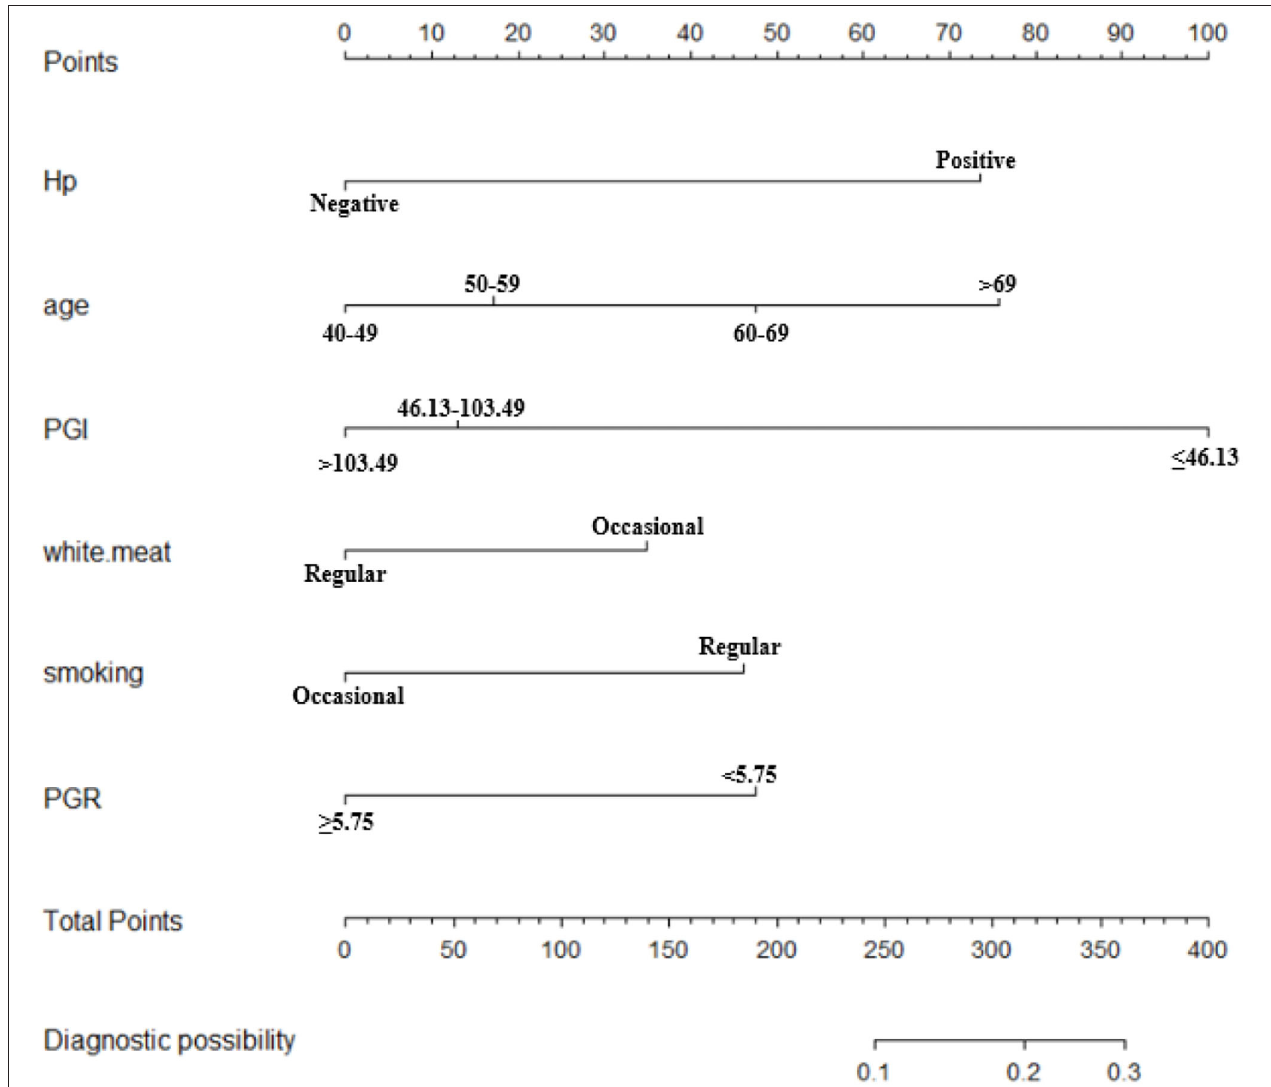
FIGURE 4 | Nomogram to predict the probability of OLGA stages III–IV in the Chinese high-risk gastric cancer population. *For the variables of eating habits (white.meat), two types of consumption frequency were provided, namely, occasional ( < 3 times a week) and regular (at least three times a week). OLGA, operative link for gastritis assessment; Hp, Helicobacter pylori ; PG, pepsinogen; PGR, PG I/II ratio.